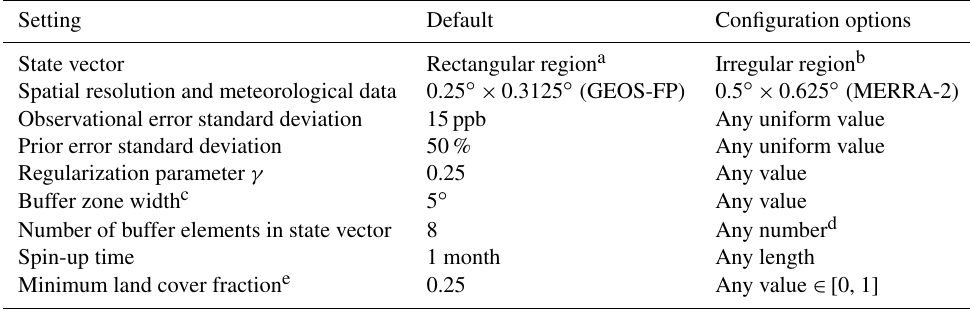
Table 2. Default IMI version 1.0 settings and configuration options. Setting Default Configuration options State vector Rectangular region a Irregular region b Spatial resolution and meteorological data 0.25 ◦ × 0.3125 ◦ (GEOS-FP) Observational error standard deviation 15ppb Any uniform value Prior error standard deviation 50% Any uniform value Regularization parameter γ 0.25 Any value Buffer zone width c 5 ◦ Any value Number of buffer elements in state vector 8 Any number d Any